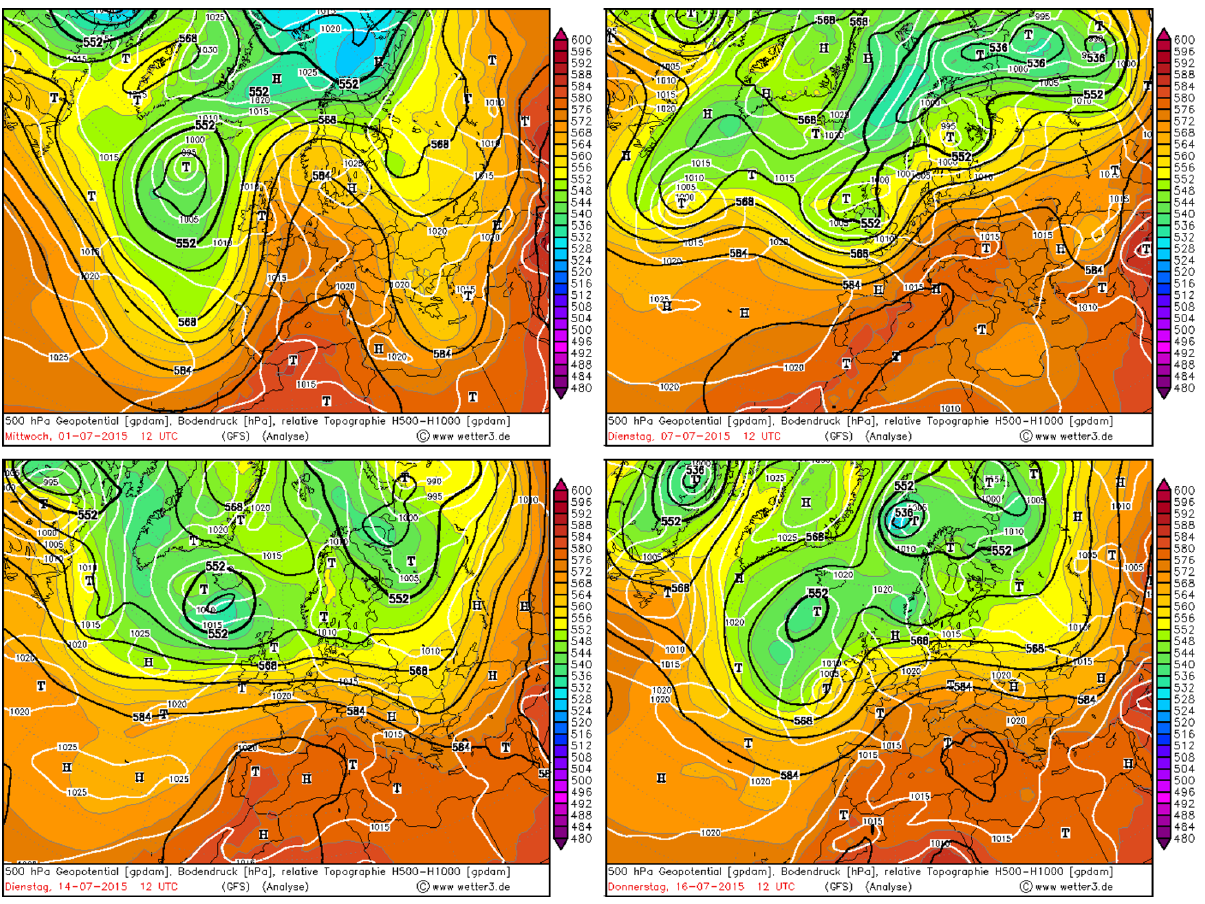
Figure 3. Synoptic meteorology with 500hPa geopotential and surface pressure at 12:00UTC for the 1, 7, 14 and 16 July of 2015 as modelled by the reanalysis model ERA-INTERIM, © http://www.wetter3.de last access: 7 January 2021). GFS: Global Forecast System.